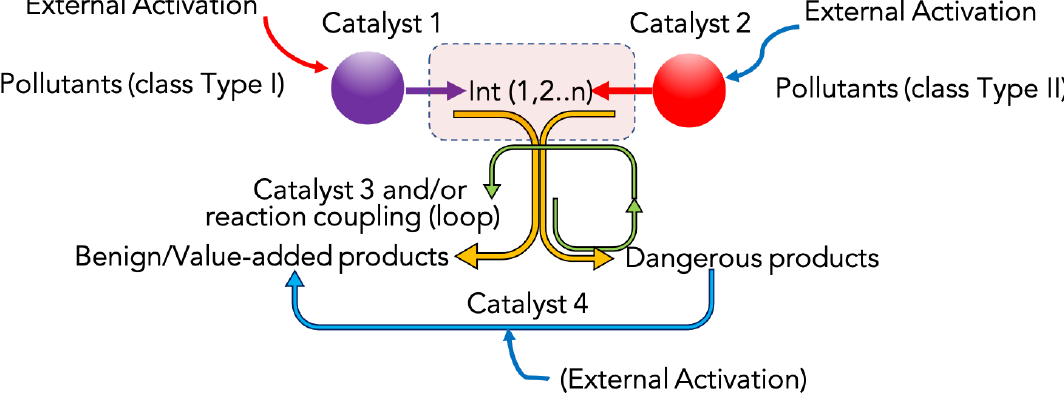
Figure 10. Scheme representing an example of systemic catalytic cycles based on synergistic interactions among different catalysts, reaction intermediates (Int 1, 2, . . . , n) and byproducts and exploited for producing safe and value-added compounds from environmental pollutants.